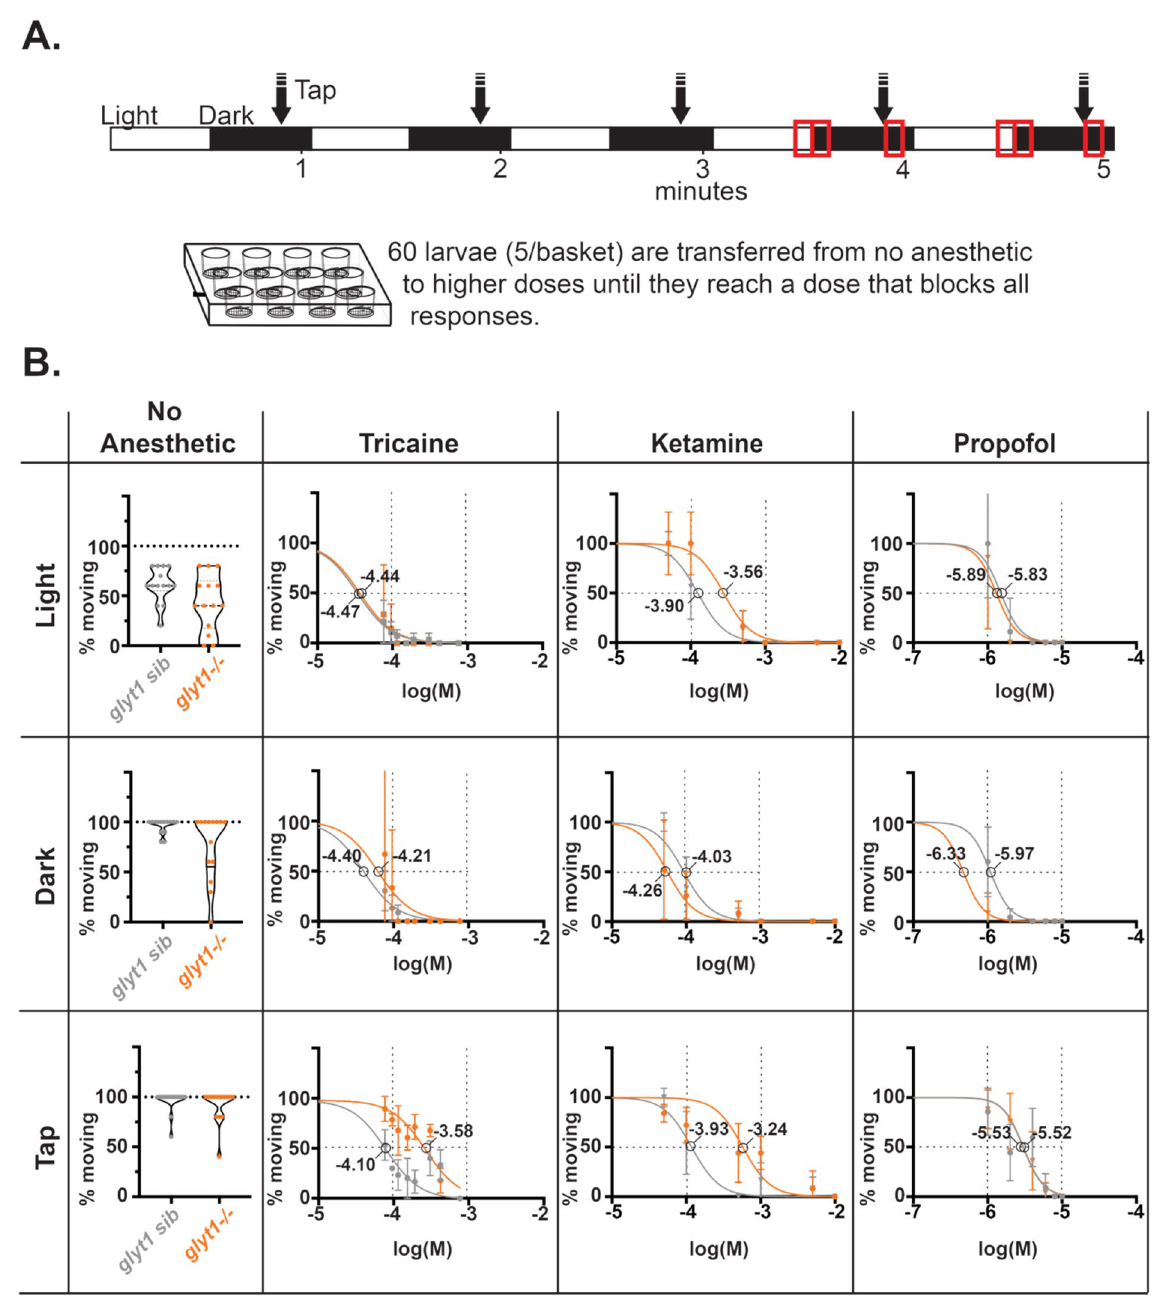
Figure 2. glyt1 siblings and glyt1−/− mutants have similar tricaine, ketamine, and propofol dose–response curves. ( A ) Our experimental approach is diagrammed. Larvae in 16-well plates, with five larvae per basket insert, were exposed to alternating thirty second intervals of light and dark, with a tap delivered after 20 s in dark; this sequence of stimuli was repeated five times for a total of five minutes. Measurements of larval swimming were made at minutes four and five (red boxes). Larvae were then exposed to increasingly higher concentrations of anesthetic by transferring baskets until all stopped moving in response to tap. ( B ) The percentage of glyt1 sibling (gray) and glyt1−/− mutant (orange) moving are plotted for three behavioral endpoints: swimming in light (top row), swimming in response to a dark transition (middle row), and swimming in response to a tap (bottom row). Percentage responding are shown for each batch in the absence of anesthetic (left-most column; n = 21 batches of five larvae for both glyt1−/− mutants and their siblings). To the right, normalized mean percentages moving are plotted against log M concentrations of Tricaine (second column; n = 3 batches of five larvae for both glyt1−/− mutants and their siblings), Ketamine (third column; n = 5 batches of five larvae for both glyt1−/− mutants and their siblings), and propofol (fourth column; n = 14 batches of five larvae for both glyt1−/− mutants and their siblings). Dose–response data were fitted with nonlinear four parameter curves constraining Hill slope in Prism. Horizontal dashed lines show 50% response and EC50 for each curve is indicated on the